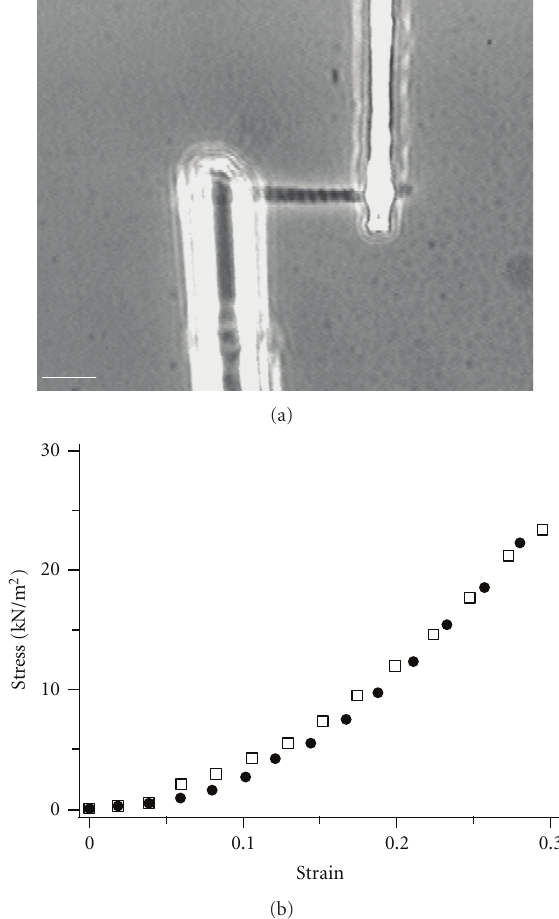
Figure 4: (a) Phase-contrast image of cardiac myofibril treated with gelsolin. Myofibril was held with two glass needles. Thick needle was moved to the left to stretch the myofibril and force was measured by the bending of the thin needle. Scale bar: 10 μ m. (b) Stress-strain relationship of myofibril treated with gelsolin. Two examples are shown. Strain is expressed relative to the slack